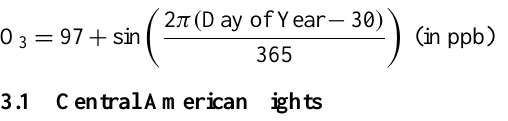
All LODs given in parts per trillion (ppt) rounded to one significant